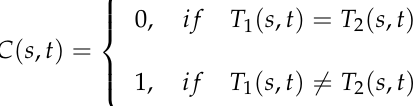
Table 5. UACI and NPCR of our innovate algorithm and other algorithms. UACI NPCR Lena 33.4685% 99.6092% Baboon 33.4687% 99.6089% In Ref. [1] (Lena) 33.48% 99.61% In Ref. [5] (Lena) 33.4477% 99.6063% In Ref. [14] (Lena) 33.4645%